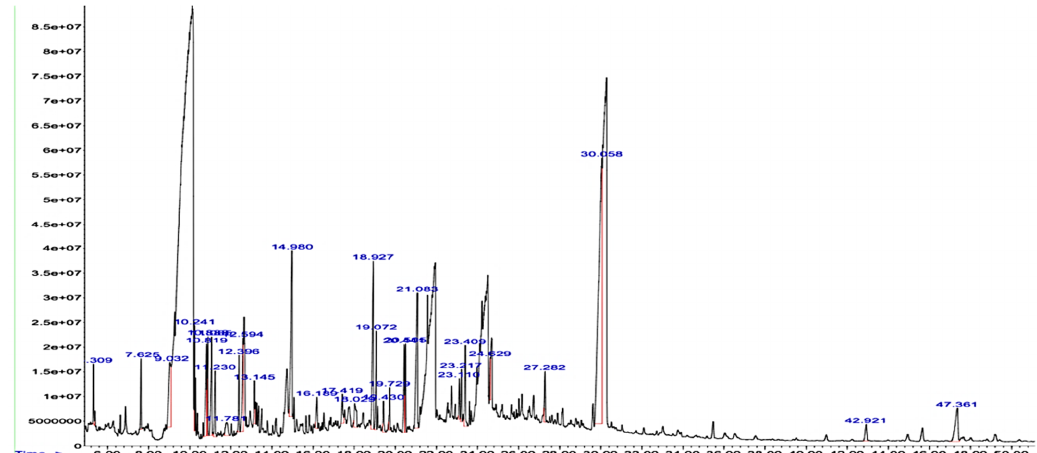
Figure 1. GC-MS analysis of a methanolic extract of T.